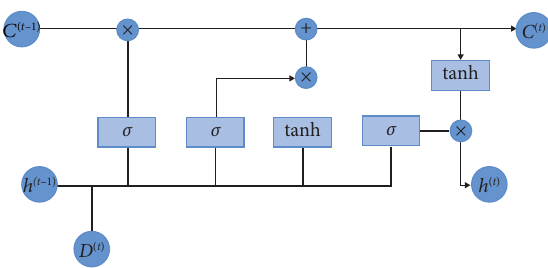
Figure 3: Te cellular structure diagram of LSTM.